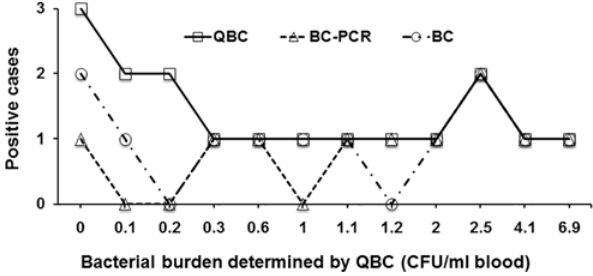
Fig 5. The bacterial burden together with the positivity of automated blood culture and blood culture PCR in 17 diagnosed paratyphoid participants. QBC: quantitative blood culture; BC-PCR: blood culture PCR; BC: automated blood